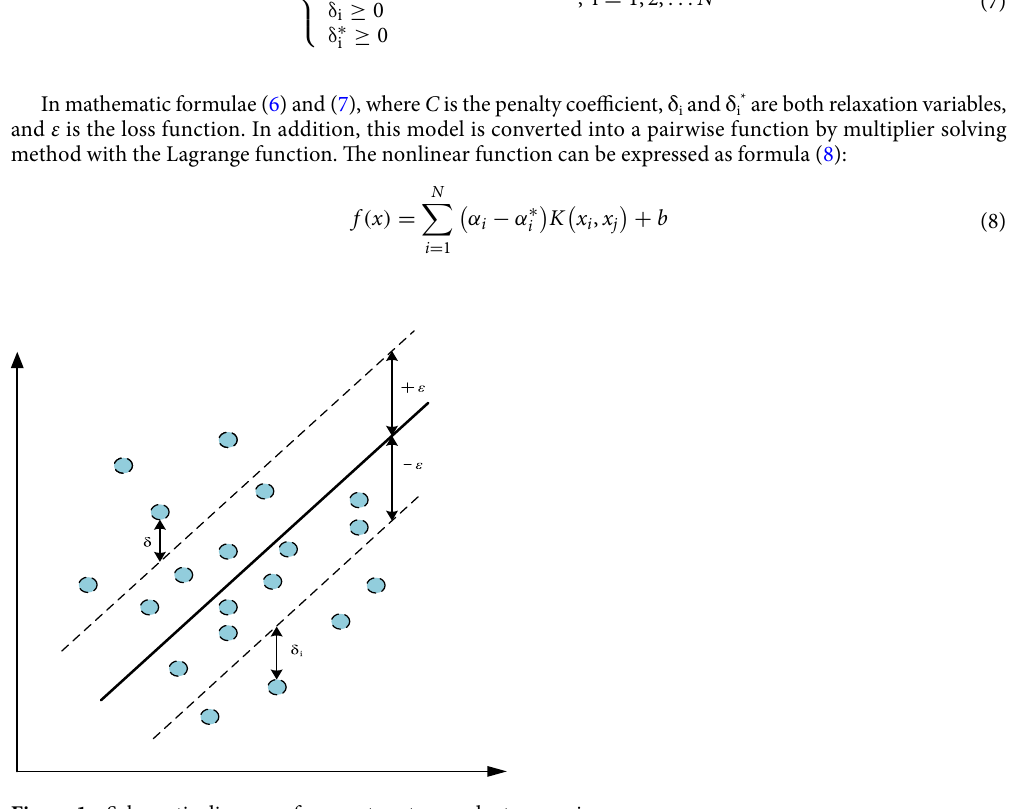
Figure 1. Schematic diagram of support vector product